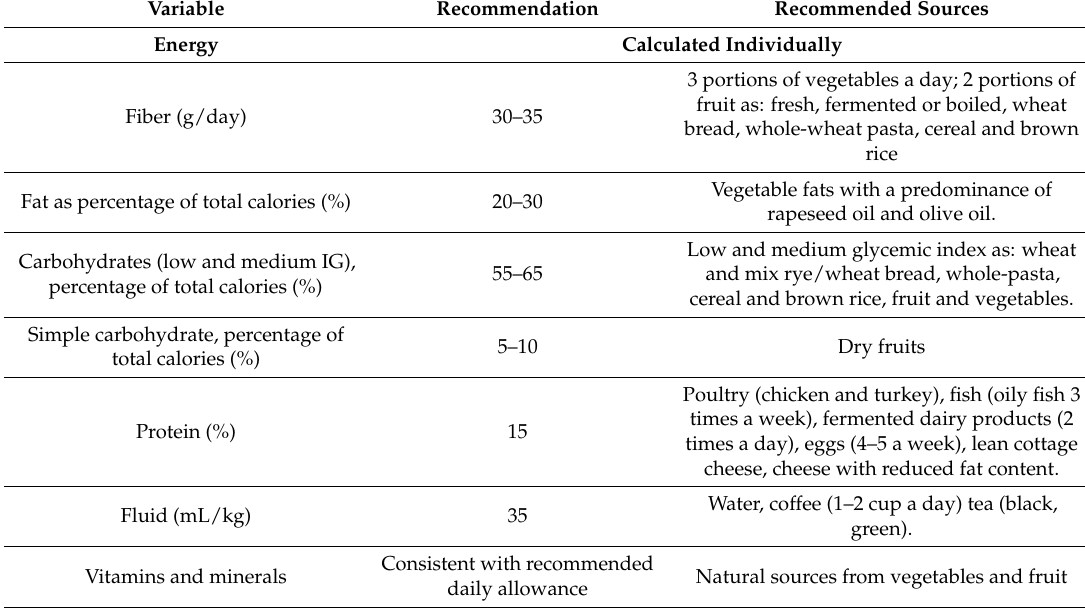
Table 1. The nutritional products used in the